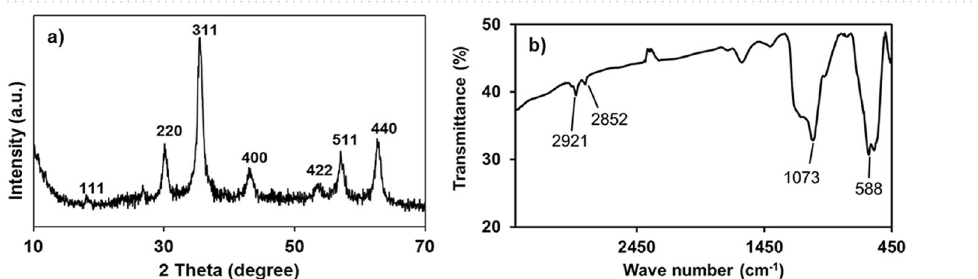
Figure 2. ( a ) XRD patterns of Fe 3 O 4 particles and ( b ) FT-IR spectra of Fe 3 O 4 @SiO 2 @C 18 particles at room temperature.